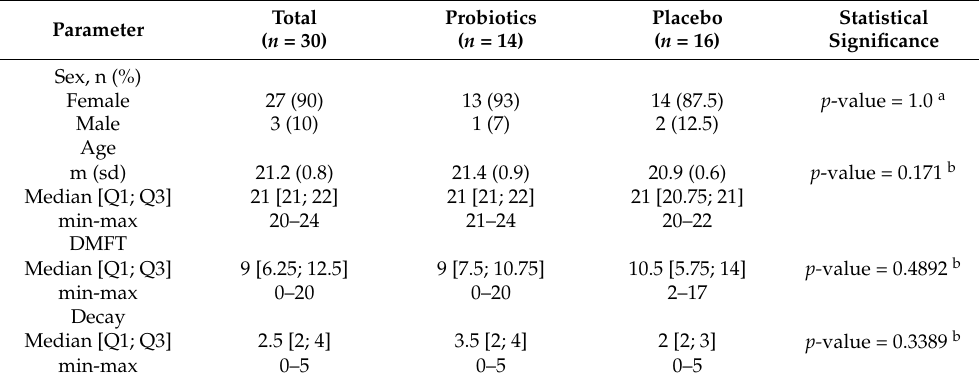
Table 3. Characteristics of subjects at